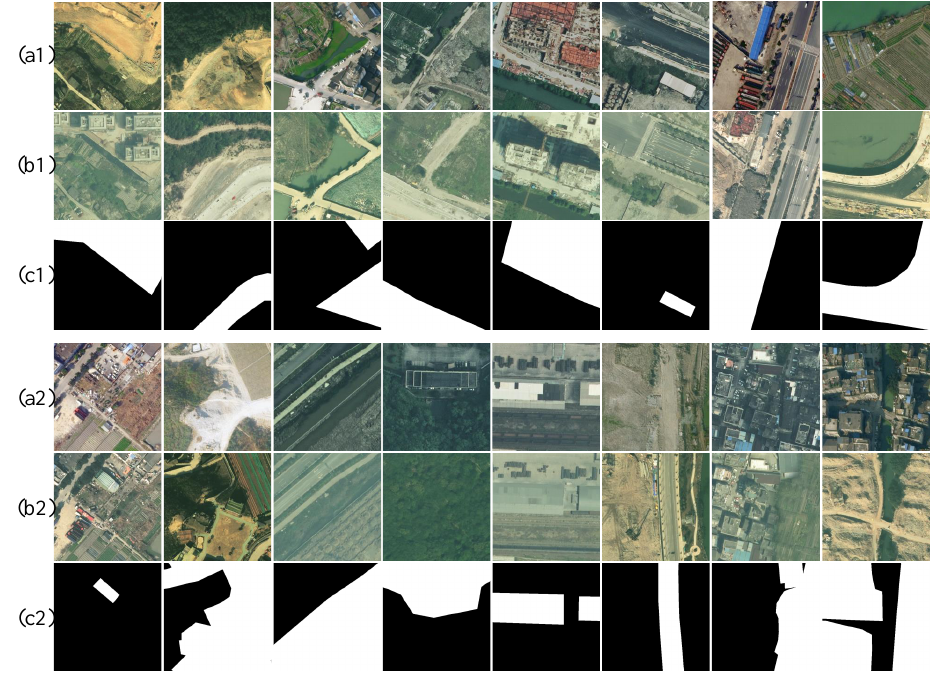
Figure 2. Some representative examples of the Wenzhou data set. ( a1 , a2 ) T 1 -time image, ( b1 , b2 ) T 2 - time image, and ( c1 , c2 ) ground truth image. White: changed pixels; Black: unchanged